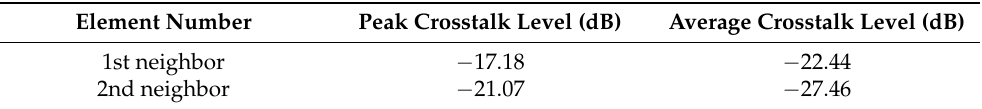
Table 3. Crosstalk levels at the nearest and next-nearest neighbor in the simulated capacitive micro- machined ultrasonic transducer (CMUT) array without aerogel coating [21].